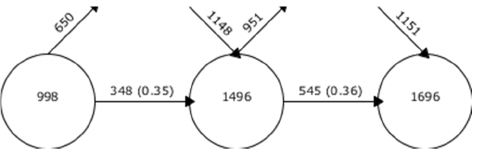
Figure 3. Continuity of keywords between contiguous intervals.